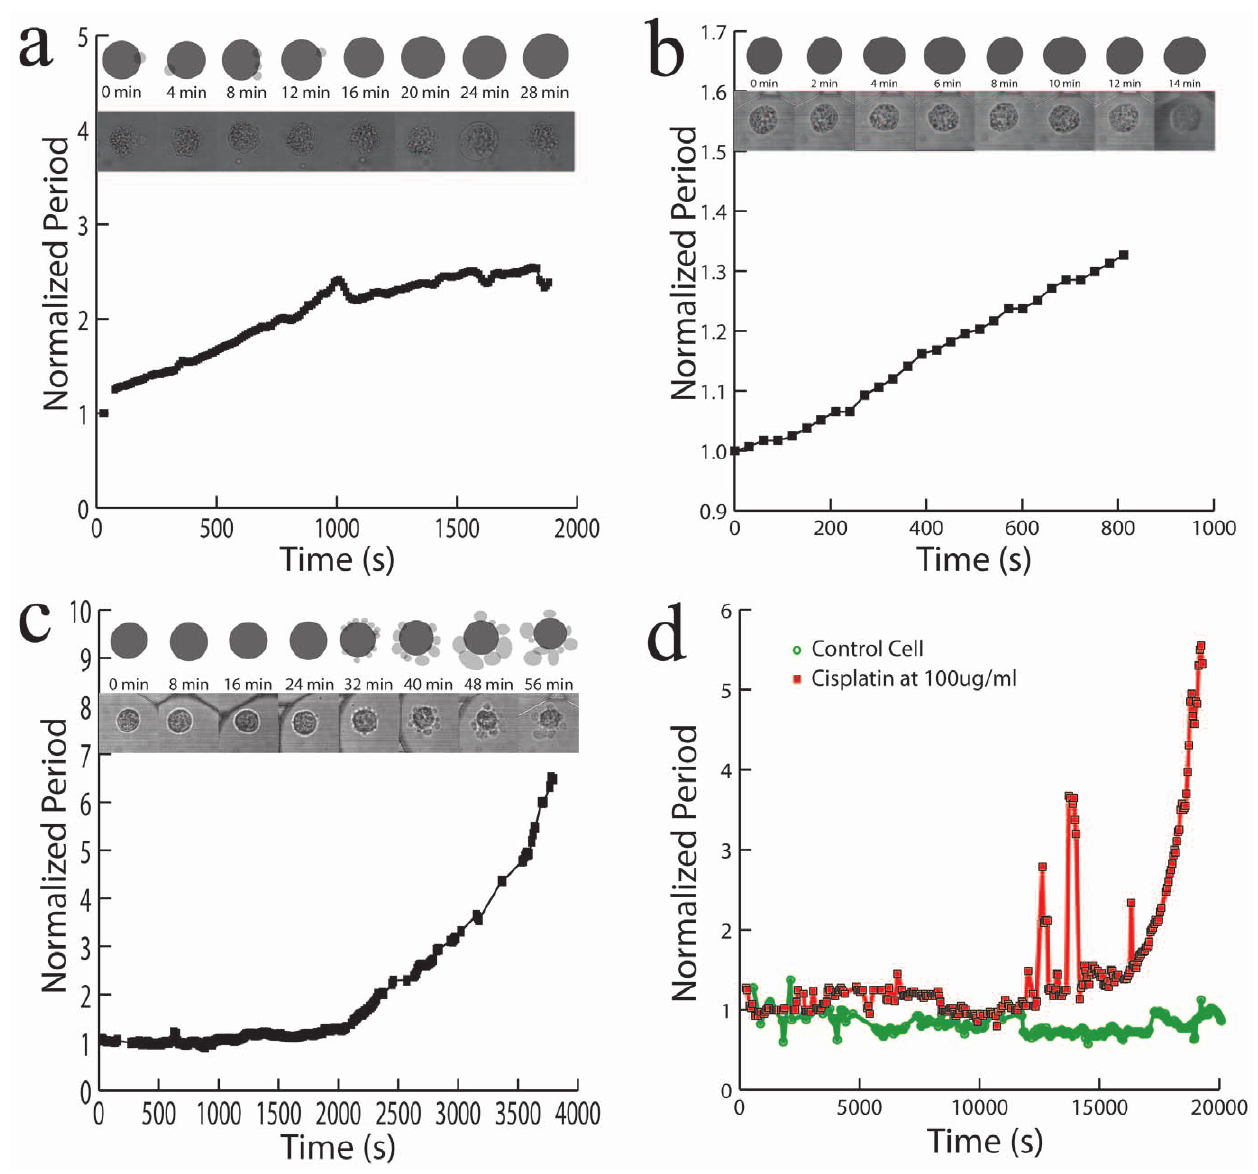
Figure 3. Changes in the rotation period of a single HeLa cell. a ) In DMEM on an agarose layer b ) In a mixture of 75% DI water and 25% DMEM c ) In a mixture of DMEM with 5% Ethanol and d ) for a live cell in DMEM (green circles) compared to a HeLa cell (red squares) in DMEM with a 100 ug/ml of Cisplatin. The Y axis is the normalized period, and the X axis is time in seconds. Lines show trend between connected points. For each graph, in the pictures above it, the bottom pictures show snapshots of the rotated cell at each indicated time, while the schematic pictures on top of it show the corresponding cell shapes (fixated cell not shown). Dark discs represent the cell cytoplasm and membrane, while grey spots show the vesicles formed at the surface, if